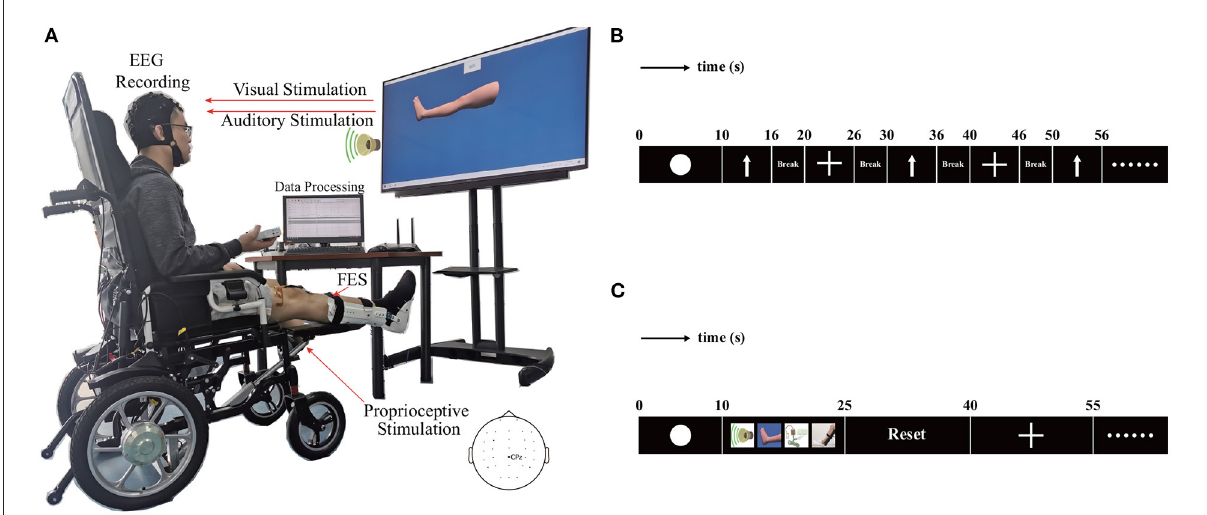
FIGURE2 The hardware structure and experimental protocol for the proposed BCI system. (A) Hardware structure. (B) Paradigm of experiment 1. (C) Paradigm of experiment 2.